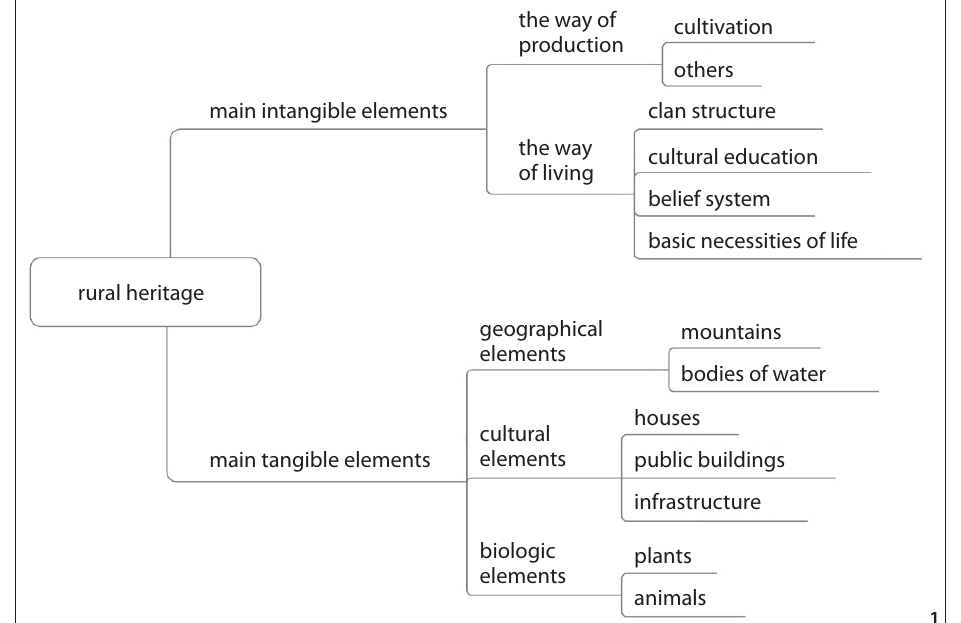
Figure 1 Constituent elements of rural heritage (Source: Shi and Zhao 2018).